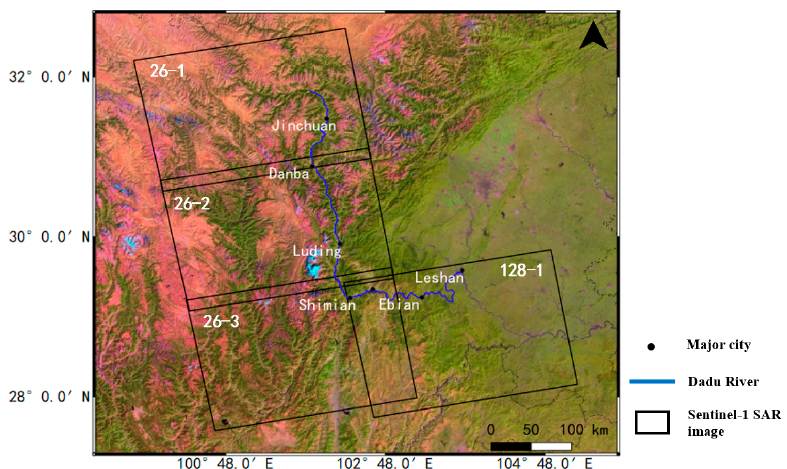
Figure 2. The location of Sentinel-1A dataset coverage (black box). Sensors 2023 , 23 , x FOR PEER REVIEW Table 1. Sentinel-1 SAR data used in the study.